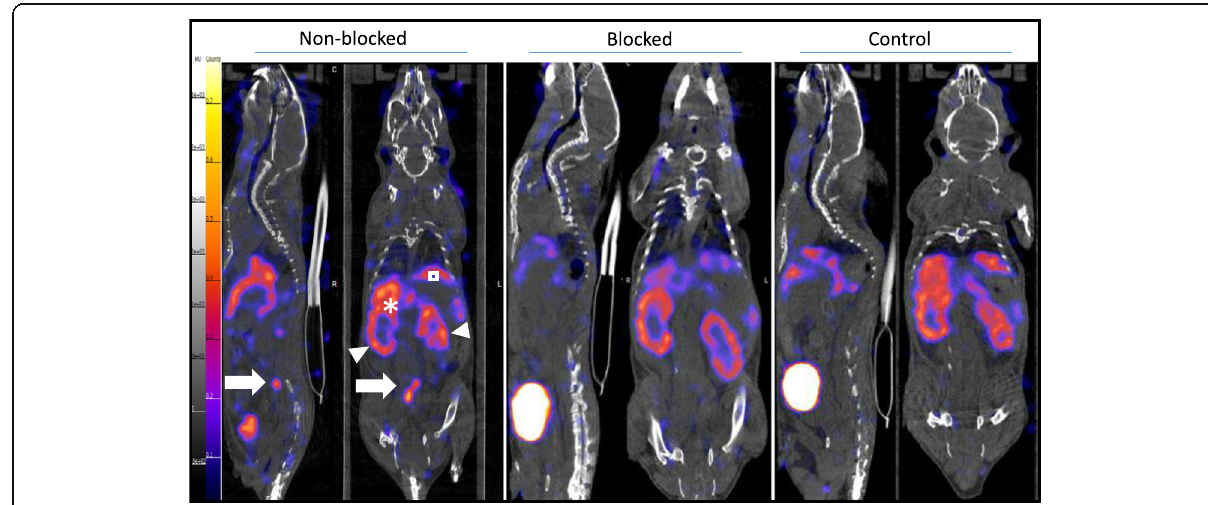
Fig. 3 Sagittal and coronal views of SPECT/CT images acquired in vivo 90 min after i.v. injection of 111 In-tilmanocept from ApoE-KO non-blocked, blocked and control mice. Note the intense focal signals in low abdominal atherosclerotic plaques of ApoE-KO non-blocked mice ( white arrows ). In contrast, no focal uptake was detected in the aortas of ApoE-KO mice after blocking with excess amount (10 nmol) of non-labelled tilmanocept and in those of control mice. Kidneys ( arrowheads ) liver ( asterisk ), spleen ( square